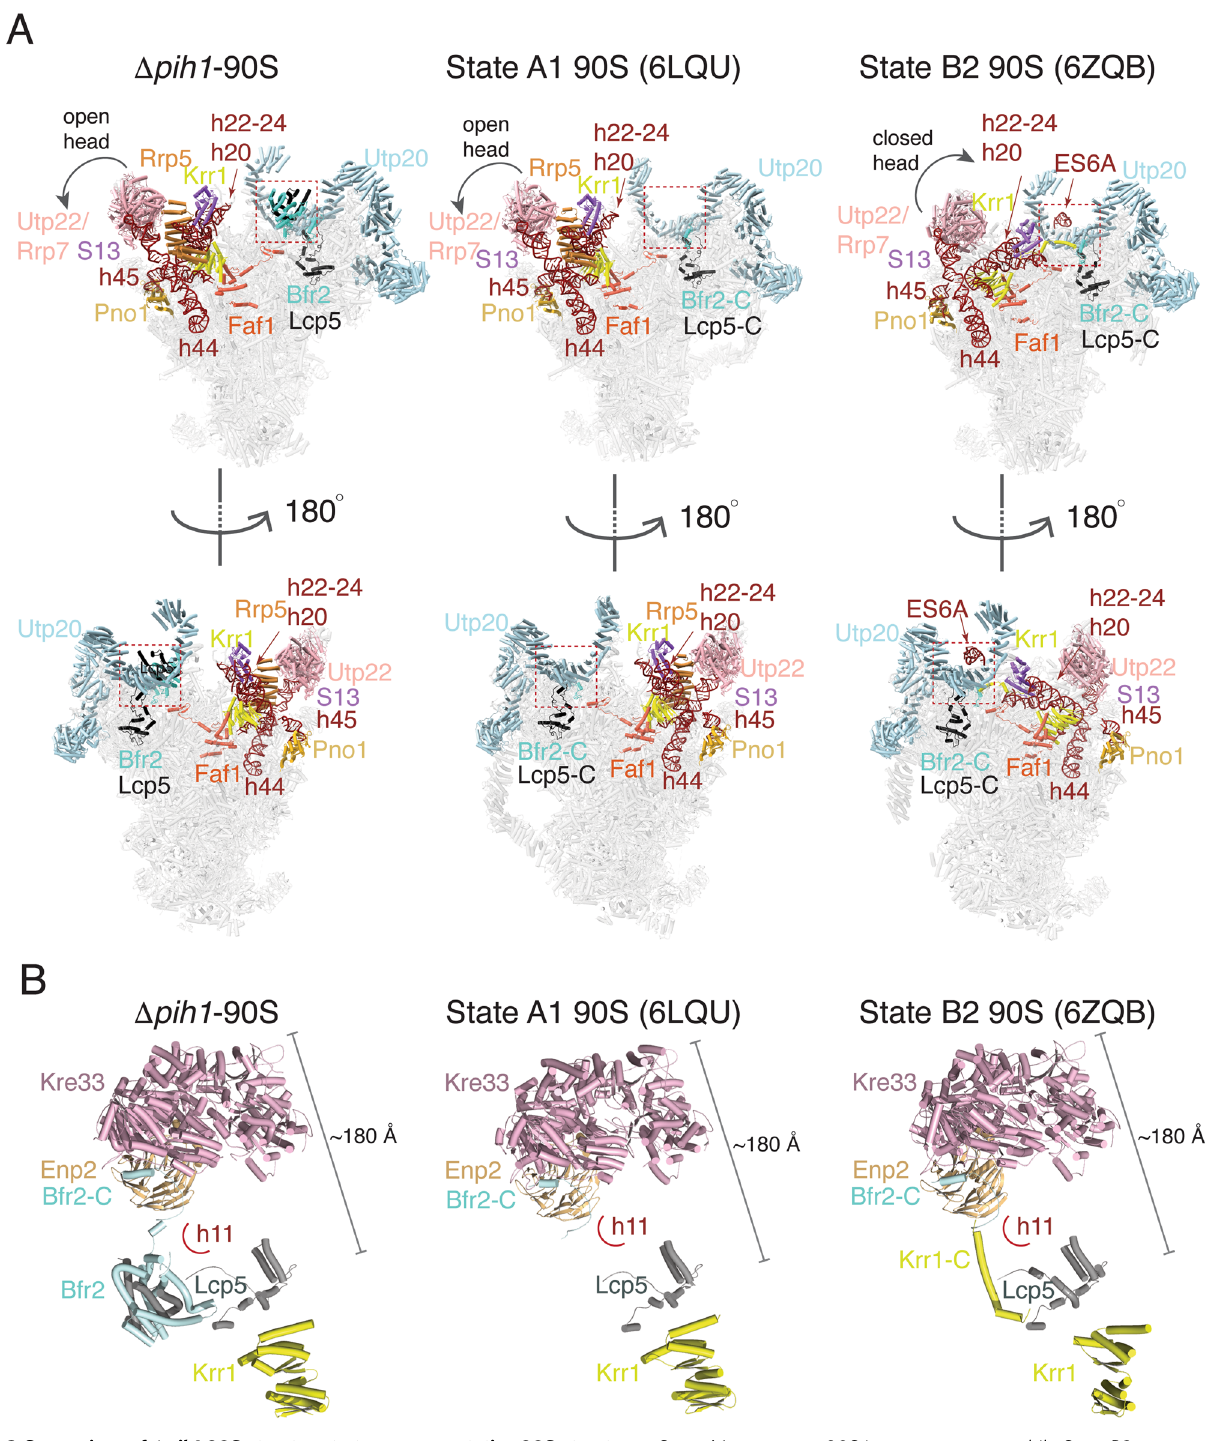
Fig. 3 Comparison of Δ pih1 -90S structure to two representative 90S structures. State A1 represents 90S in a storage state while State B2 represents a successive Krr1-bound state. a Overviews in two opposite orientations (upper and lower) of 90S structures with labeled key factors shown as colored ribbons. The boxed region indicates where Bfr2-Lcp5 is bound. Left, Δ pih1 -90S, Middle, State A1 of 90S (PDB ID: 6LQU), Right, State B2 of 90S (PDB ID: 6ZQB). b Structure of the Kre33 module and Krr1 in the three states as shown in a . Each protein is colored and labeled. The 18S helix 11 (h11) is schematically shown as an arc. Bfr2-C and Krr1-C refer to the C-terminal end of each of the two proteins. with tester strains. Appropriate haploids were then con fi rmed by PCR and DNA To tag the mutant strains, heterozygous strains were created by crossing the sequencing. BY4741 pwp2-TAP-his/kre33-TwinStrepII-hph haploid strain with the pih1- Δ BY4742 strain followed by sporulation. At least 20 tetrads were dissected on YPD agar plates from each sporulated heterozygous strain. Tetrad dissection Puri fi cation of 90S from Δ pih1 cells . The Δ pih1 /pwp2-TAP/kre33-TwinStrep plates were replica plated onto SD-HIS, YPD + G418, YPD + Hygromycin B plates for genotyping. Mating types of haploids were determined by crossing cells were grown at 30°C in complete medium YPD (1% yeast extract, 2% peptone, COMMUNICATIONS BIOLOGY| (2022) 5:523